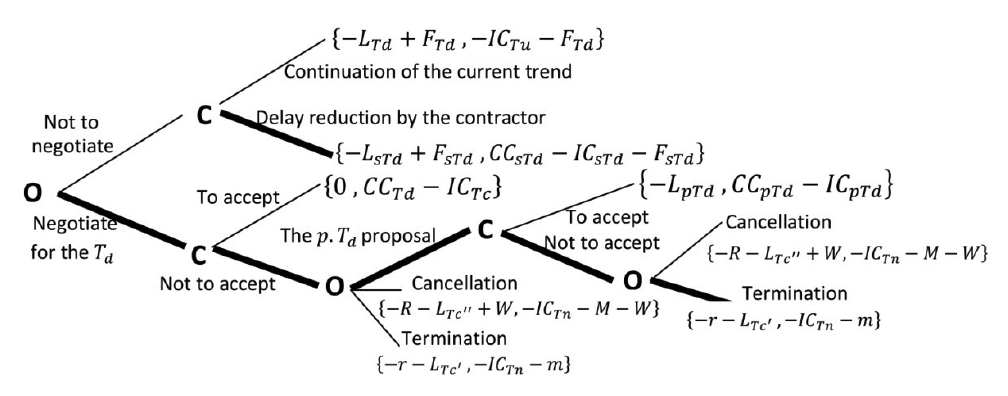
Fig. 2. Game tree for resolution 1 – form 1